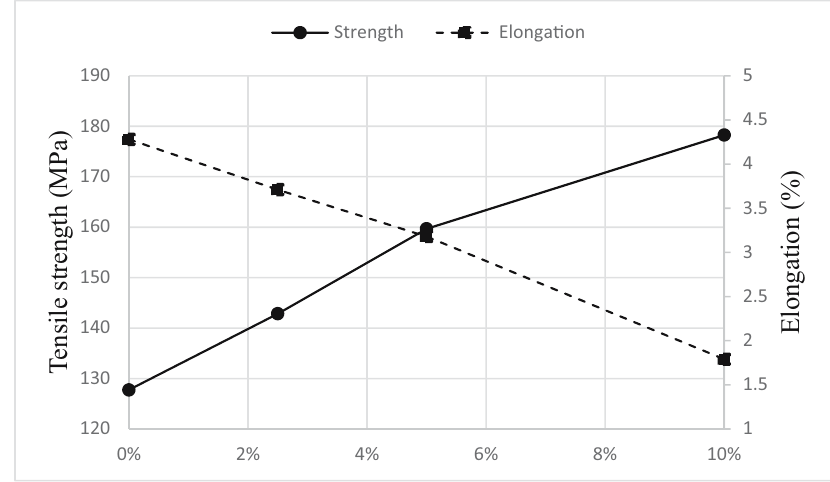
Figure 7: Tensile strength and elongation of composite samples vs alumina Vol%.